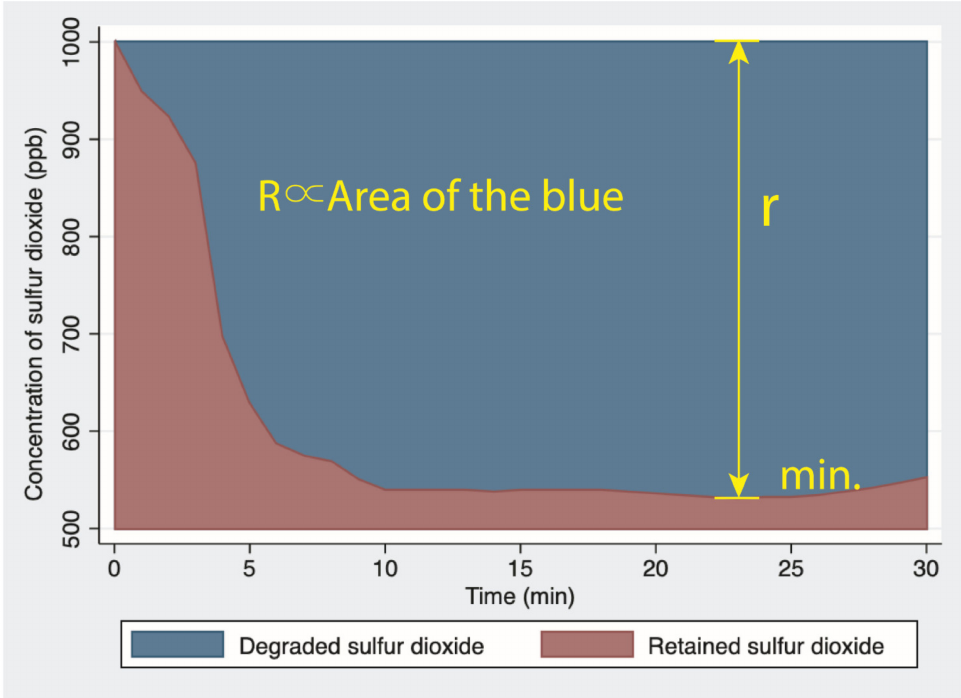
Figure 4. Profile of the real-time concentration of sulfur dioxide and the visualized test